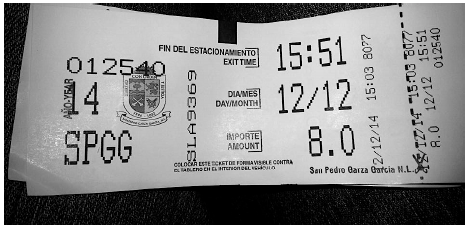
Figure 30. Ticket from San Pedro Garza García. It does not contain instructions informing the user what to do with the ticket. It is confusing to read.